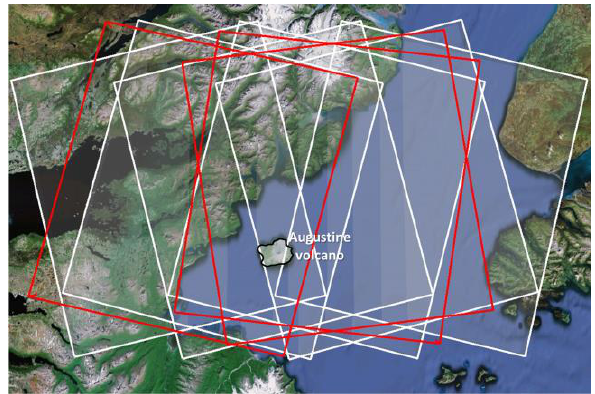
(1) Figure 3. Ground tracks of neighboring SAR image swaths